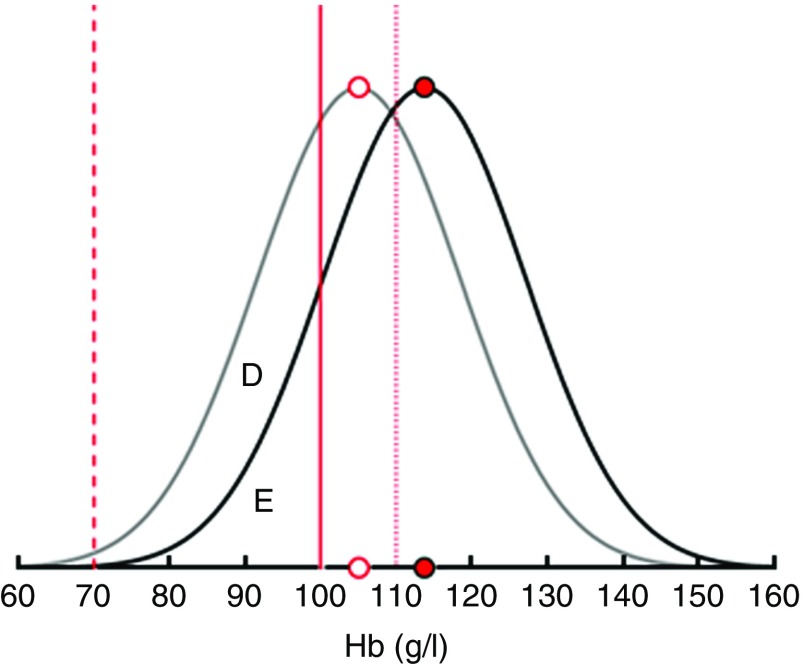
Translating the demand effects into changes in iron-deficiency anaemia (IDA) prevalence among 6–23-month-old children from Faisalabad and Hyderabad districts, Pakistan. The figure shows that an increase in the consumption of fortified packaged complementary foods by 75 g (the recommended daily dose) shifts the Hb distribution to the right by 8·7 g/l and thus reduces the share of children with IDA by the area D. Area E represents the share of children with IDA who remain deficient even after the maximum intervention (
, limit mild anaemia;
, limit moderate anaemia;
, limit severe anaemia;
, average Hb before intervention;
, average Hb with intervention)